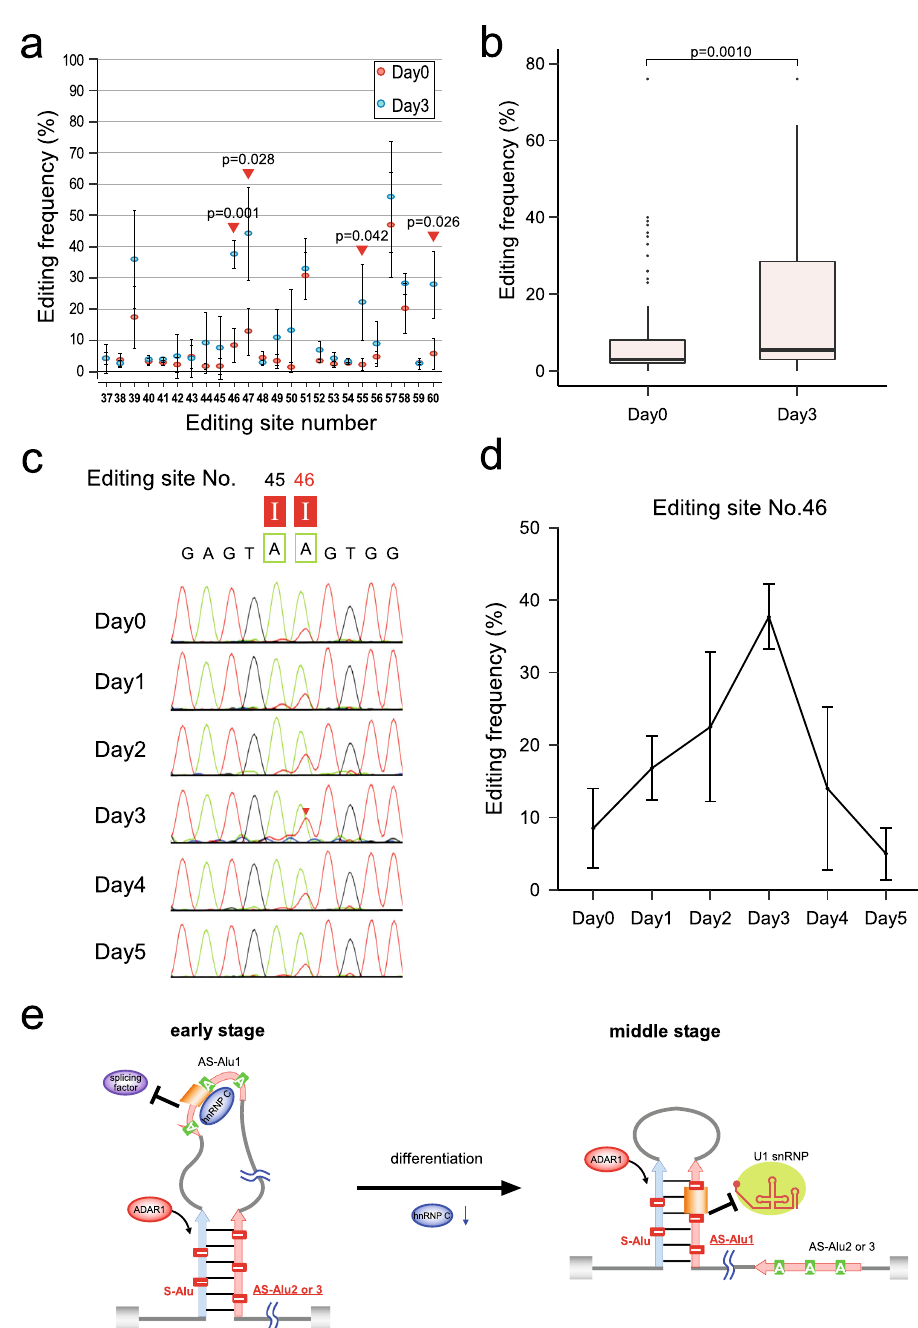
Fig. 3 Dynamic alteration of A-to-I RNA editing during myoblast differentiation. a Alteration of A-to-I RNA editing frequency in AS-Alu1 from Day 0 (red) to 3 (blue). Data are presented as mean values ±S.D. The positions showing statistical signi fi cance [ p < 0.05, determined by unpaired two-tailed t test; n = 4 (Day 0) and 3 (Day 3) biologically independent samples] are indicated by red triangles. Source data are provided in Source Supplementary Data 1. b The distribution of the A-to-I RNA editing frequency in AS-Alu1 on Days 0 and 3 is shown as box plots (center lines indicate median, box limits indicate upper and lower quartiles, whiskers indicate 1.5× interquartile range and points indicate outliers). Error bars denote S.D. Statistical signi fi cance was determined by unpaired two-tailed t test; n = 96 (Day 0) and 72 (Day 3). Source data are provided in Source Supplementary Data 1. c Sanger sequences of the 5 ′ SS of the Alu exon in AS-Alu1 of SELENON mRNAs in differentiating Hu5/KD3 cells on the indicated days. The A-to-I RNA editing sites are boxed, with the site number shown above. d Frequency of editing site No. 46 in Hu5/KD3 cells on different differentiation days. Data are presented as mean values ±S.D.; n = 4 (Day 0 and Day 2), 5 (Day 1), and 3 (Day 3 – 5) biologically independent samples. Source data are provided in Source Supplementary Data 1. e Schematic model of conformational changes in SELENON pre-mRNA from the early-to-middle stage of differentiation. At the early stage, hnRNP C binds to AS-Alu1, and then S-Alu forms a double-stranded structure with AS-Alu2 or 3. A-to-I RNA editing occurs in this double strand. At the middle stage, the level of hnRNP C decreases. AS-Alu1 forms a double-stranded structure with S-Alu, which is recognized by ADAR1, which then performs A-to-I RNA editing in this double-stranded region, including the 5 ′ SS of the Alu exon, thereby inhibiting U1 snRNA recognition. Source data and unprocessed gel images are provided in Source Data fi